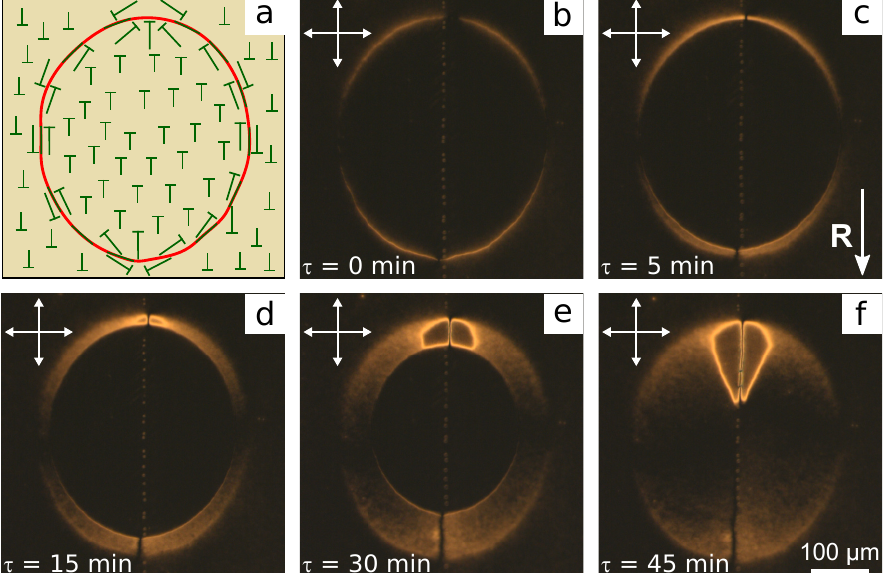
Figure 6. ( a ) Scheme of the director orientation at the substrate covered with PiBMA:PMMA:LN- 396 = 80:20:20 mixture before the voltage action. The position of the domain border is indicated by the red line. POM photos of the sample area with the domain ( b ) before and after the action of voltage U = 10 V during τ equal to: ( c ) 5 min, ( d ) 15 min, ( e ) 30 min, and ( f ) 45